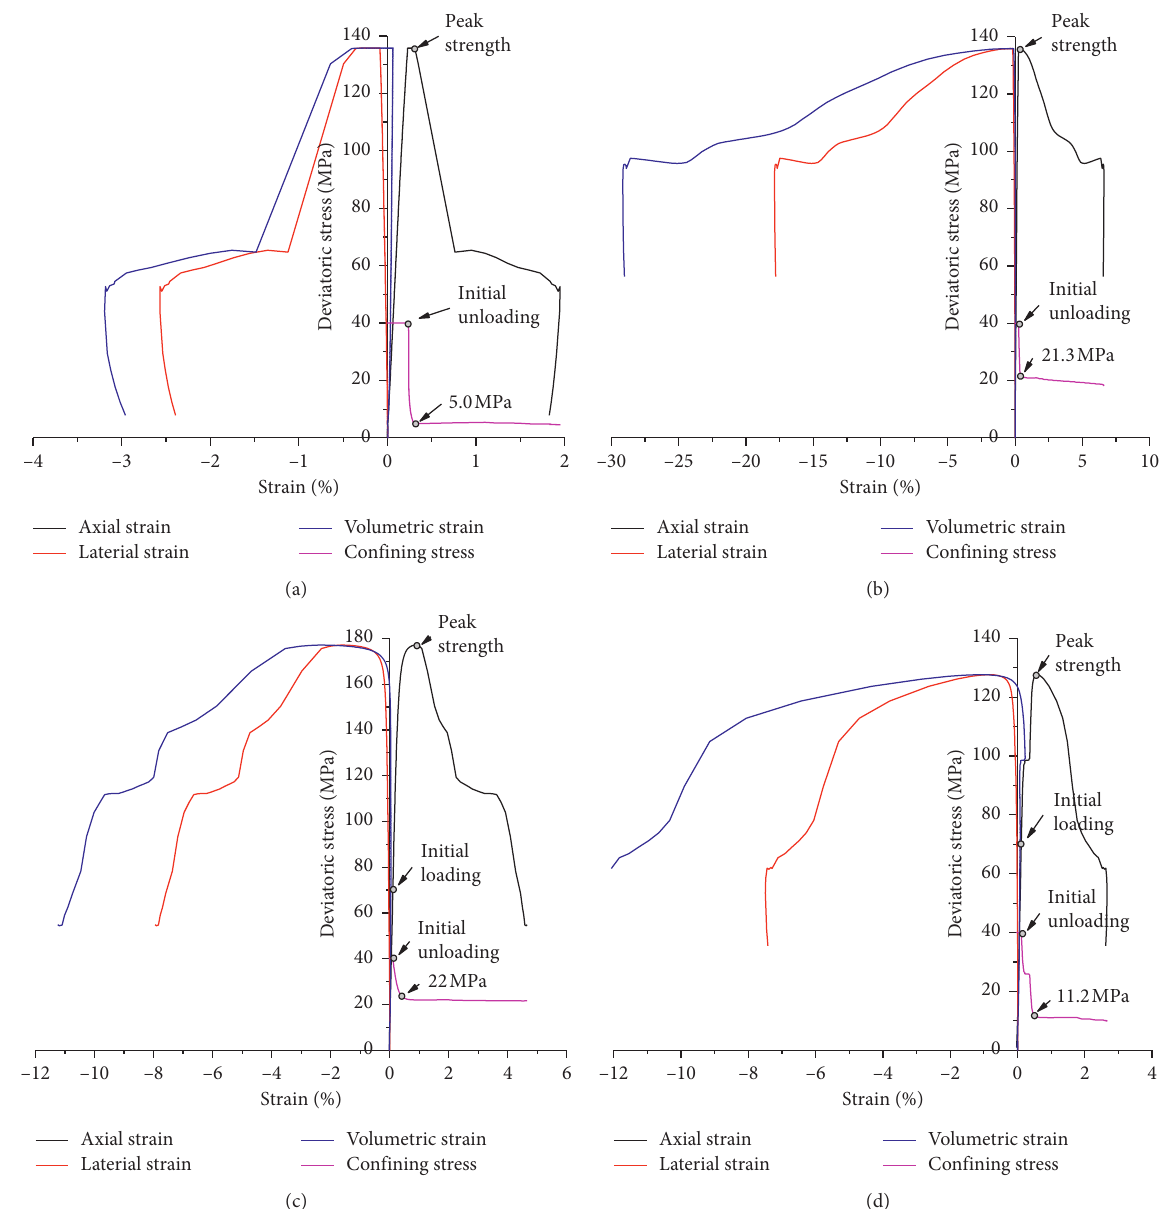
Figure 6: Stress-strain curves in complex loading-unloading stress tests (confining pressure: 40MPa): (a) sample 20; (b) sample 22; (c) sample 23; and (d) sample